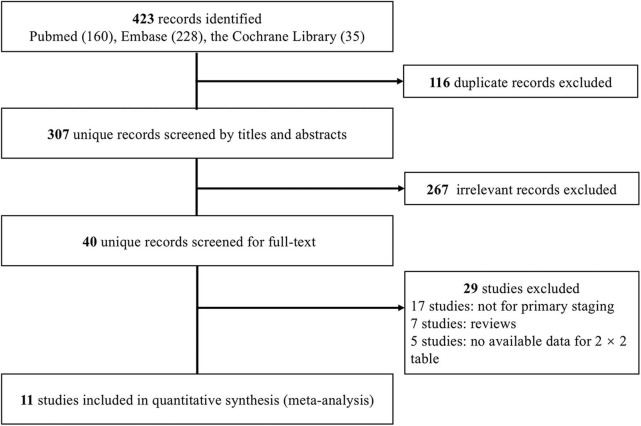
Flow chart of study selection.